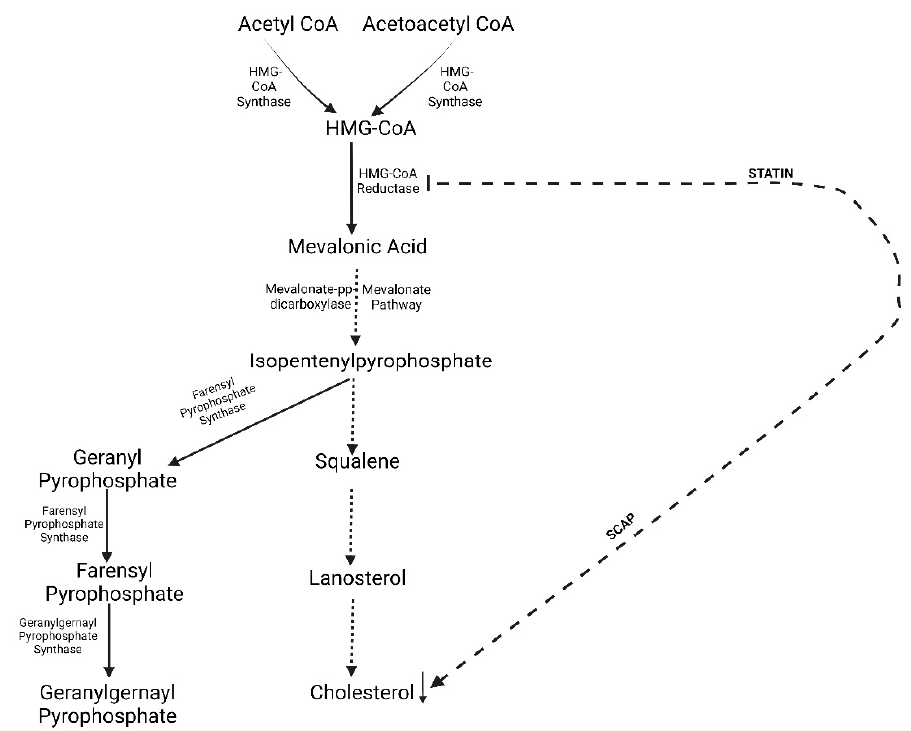
Figure 1. The mechanism of the action of statin. Acetyl CoA or Acetoacetyl CoA are converted to HMG-CoA by HMG-CoA synthase and HMG-CoA is converted to mevalonic acid by HMG-CoA reductase. This latter step is crucial in the formation of cholesterol. To mediate the formation of cholesterol, statins inhibit the enzyme HMG-CoA reductase. HMG-CoA reductase synthesis is regulated by the steroid regulatory element binding proteins (SREBP). The binding of SCAP to SREBP activates HMG-CoA reductase. Therefore, if SCAP is inhibited, then HMG-CoA reductase will be inhibited and will consequently inhibit cholesterol synthesis. Cholesterol is also able to mediate its own availability by either inhibiting or activating SCAP. ↓ =